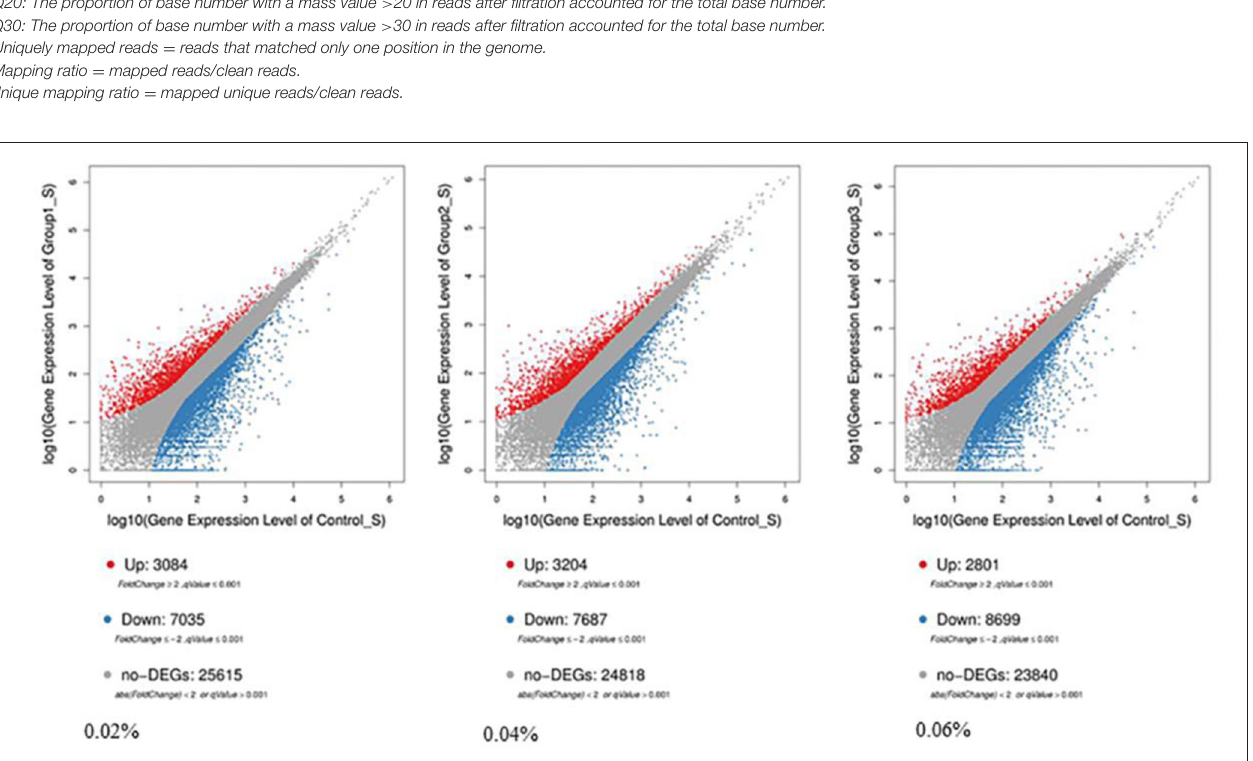
FIGURE 1 | Comparison of differentially expressed genes between control and quercetin (0.02, 0.04, and 0.06%). The volcano plot shows correlations in the gene-rich dimension. The red and blue dots represent significantly upregulated and downregulated genes by quercetin,